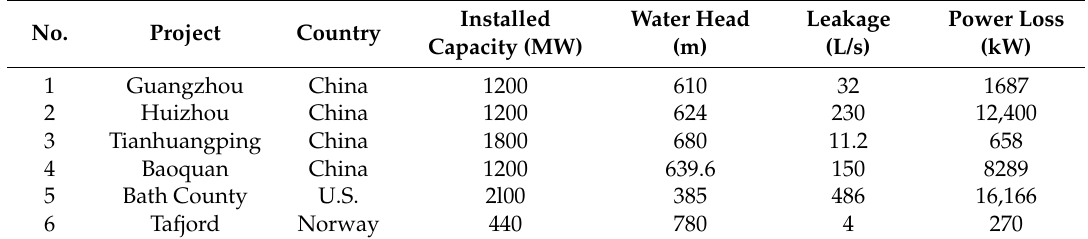
Table 2. Leakage events occurred in the pumped-storage power